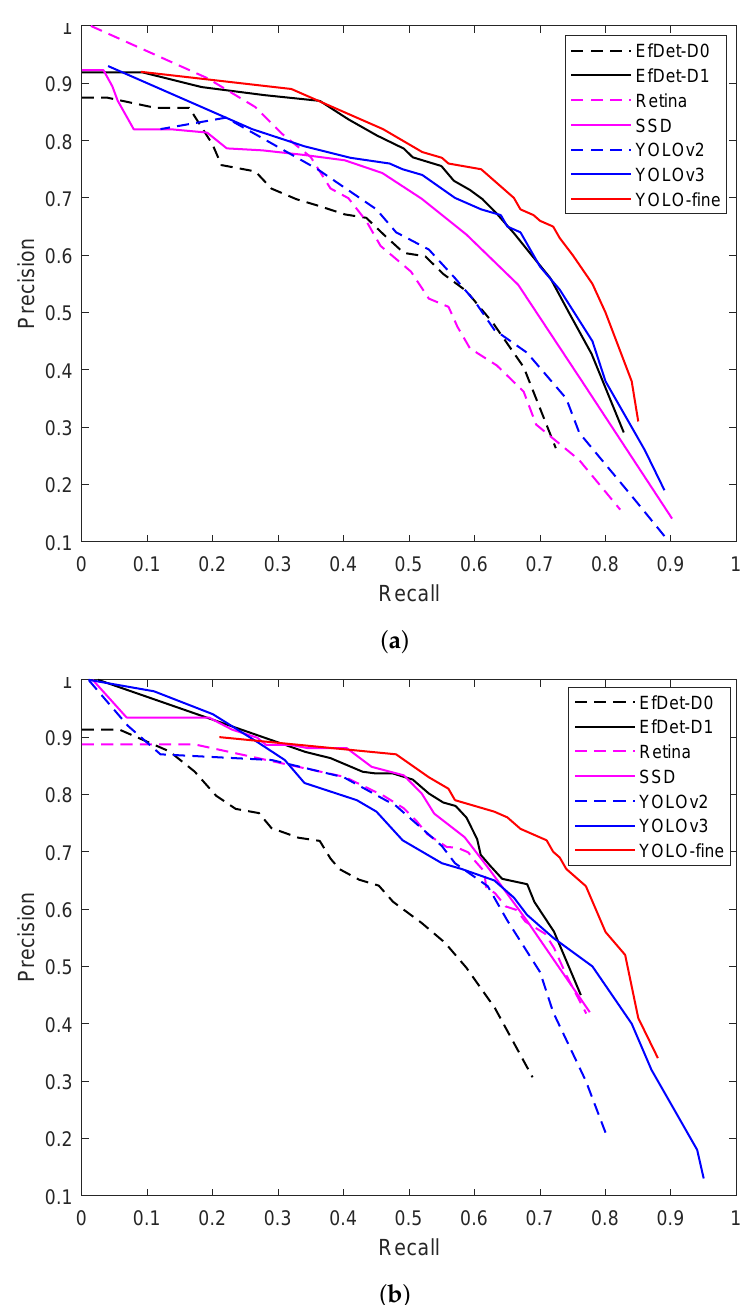
Figure 6. Comparison of recall/precision curves for the 25-cm VEDAI512 dataset. ( a ) color version; ( b ) infrared